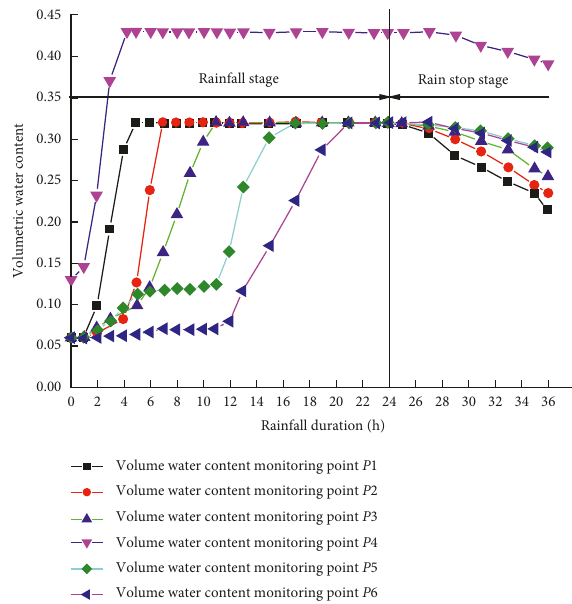
Figure 7: Variation law of volumetric water content under short- time